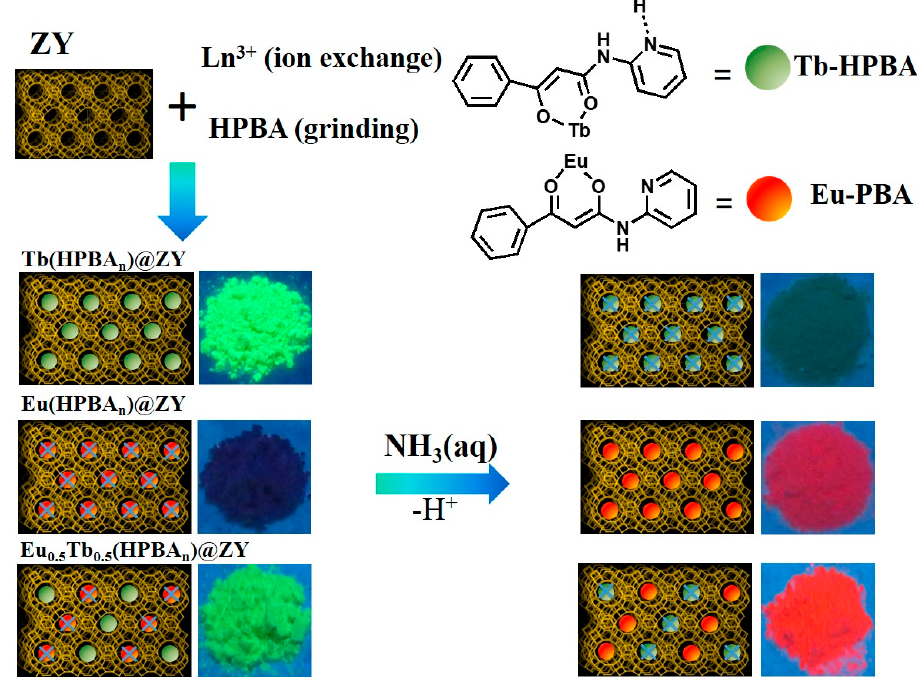
0.5 Tb 0.5 (HPBA n )@ZY ( c